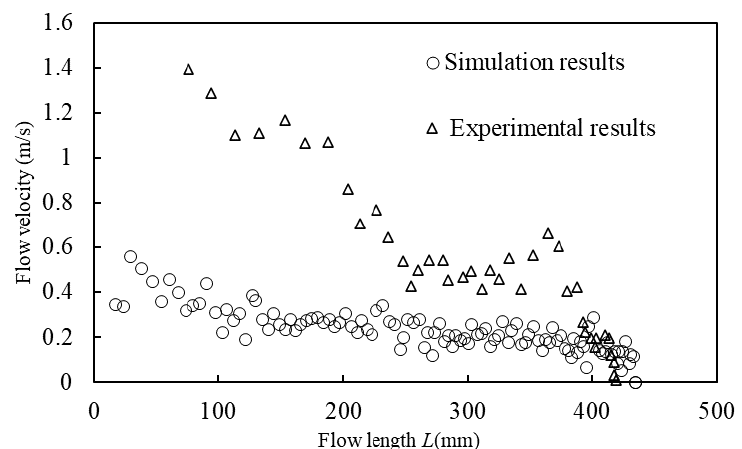
Figure 11. Relationship between flow length and flow velocity